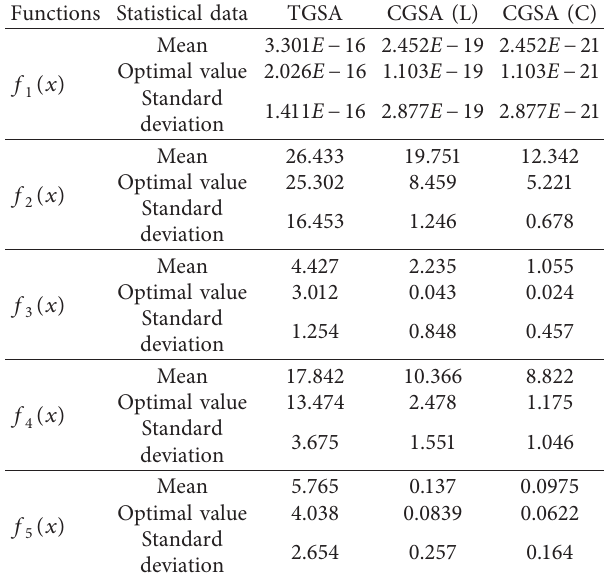
Table 2: Comparison of optimized results from standard testing